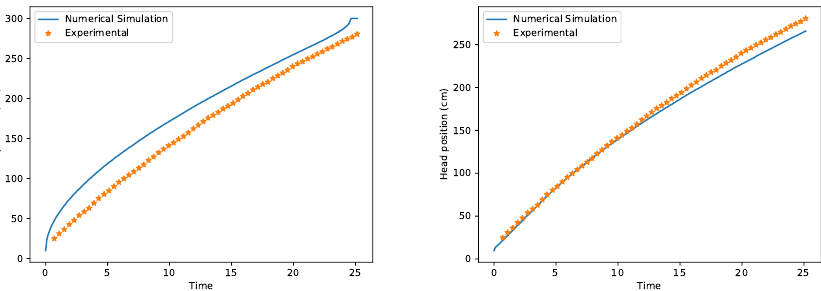
Figure 26. Evolution of the head of the gravity current over time. The left figure depicts the problem with M = 15 number of layers while the right shows the case with M =